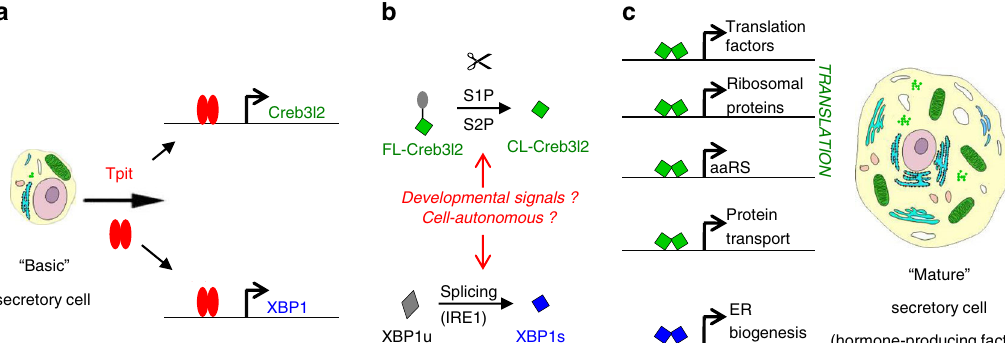
Fig. 6 Developmental mechanism to establish high capacity secretory cells. Freshly differentiated pituitary cells have basic secretory features and acquire the features of hormone-producing factories during early post-natal development under the concerted actions of two bZIP transcription factors Creb3l2 and XBP1. This is controlled by the determination transcription factor Tpit in pituitary POMC cells (likely PDX1 in pancreatic β cells and BLIMP1 in activated B cells). a In pituitary, Tpit activates expression of Creb3l2 and XBP1 by directly targeting their genes. b Both factors require activation through either proteolytic cleavage (Creb3l2) or alternative splicing (XBP1) and this appears to be either cell-autonomous in normal development or may be regulated by developmental signals as shown for TGF β in liver 23 . c Translation capacity and protein transport are enhanced by the scaling action of Creb3l2 directly targeting the promoters of a large number of genes involved in translation including genes for regulatory factors, ribosomal proteins, and tRNA aminoacyl transferases. In parallel, XBP1 stimulates ER biogenesis without triggering the protein stress response, thus activating the physiological UPR